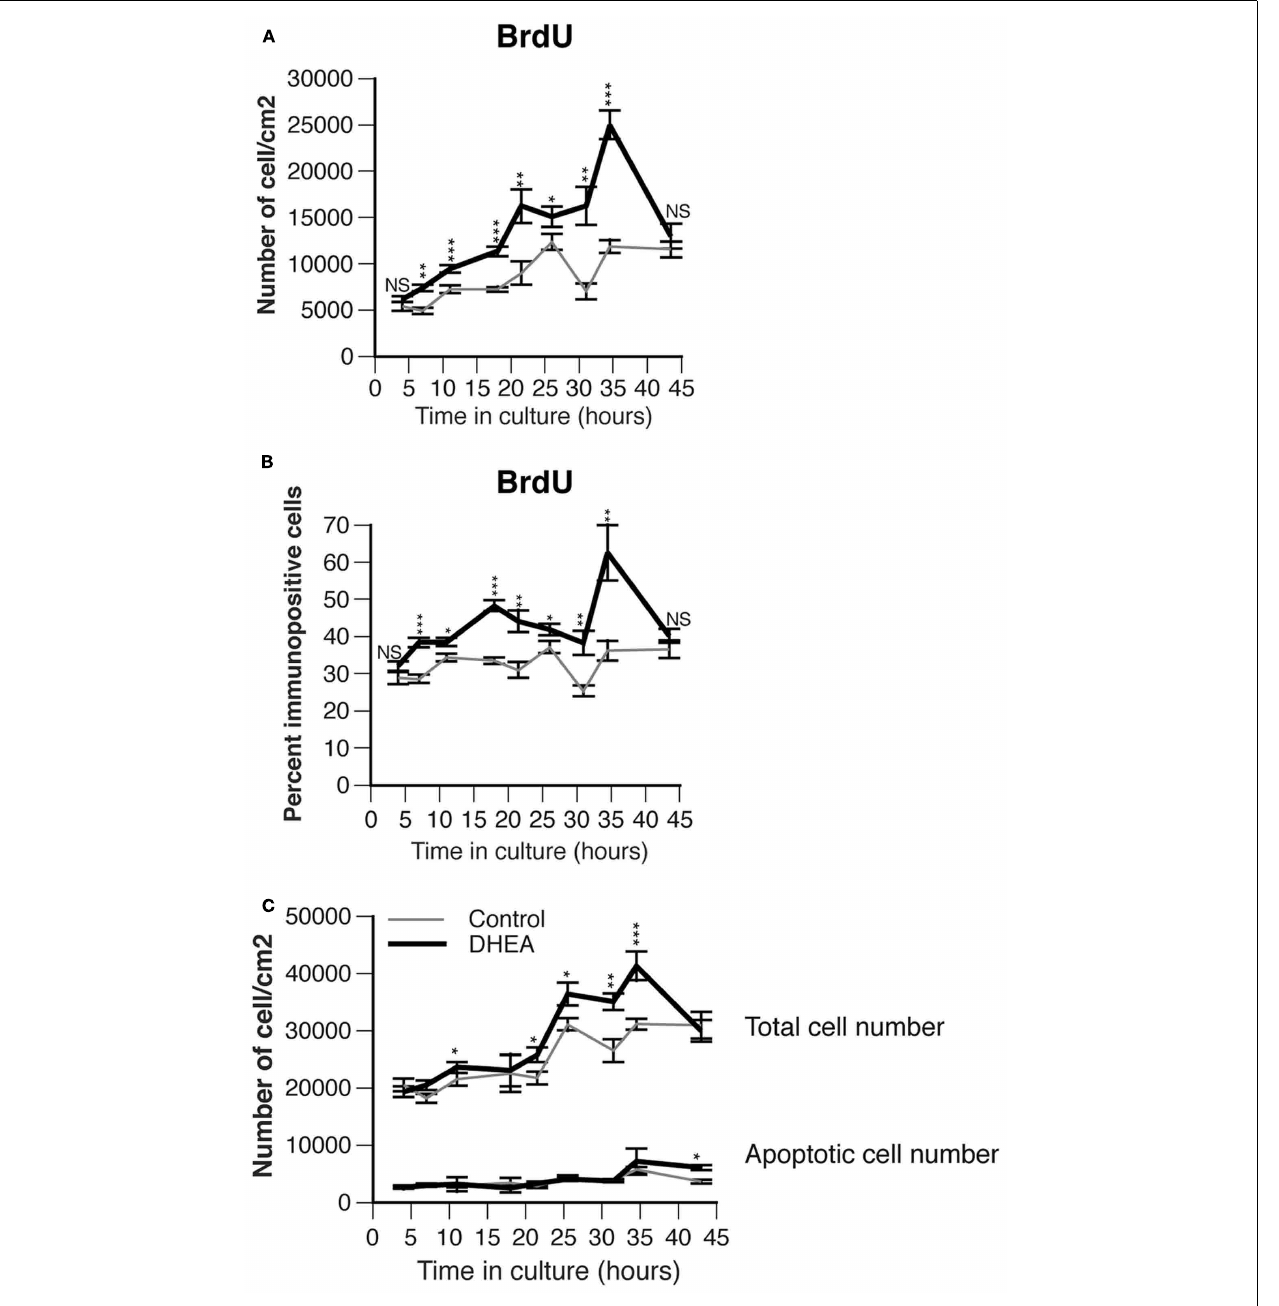
cultures at each time point. (B) Percent of BrdU immunopositive cells per total cell number.Values represent the means ± SEM of five independent platings. Analyses similar to those in A were performed and asterisks show the significance level between control and DHEA-treated cultures at each time point. (C) Effect of DHEA on growth curve and number of apoptotic cells in primary culture. Cells were cultured in the presence (black line) or absence (control, gray line) of DHEA.The total cell number was counted after staining with Hoechst or wheat-germ agglutinin coupled to a fluorochrome and expressed as a number of cells/cm 2 . Apoptosis was assessed withTUNEL analysis and expressed as a number of apoptotic cells/cm 2 .Values represent the means ± SEM of five independent